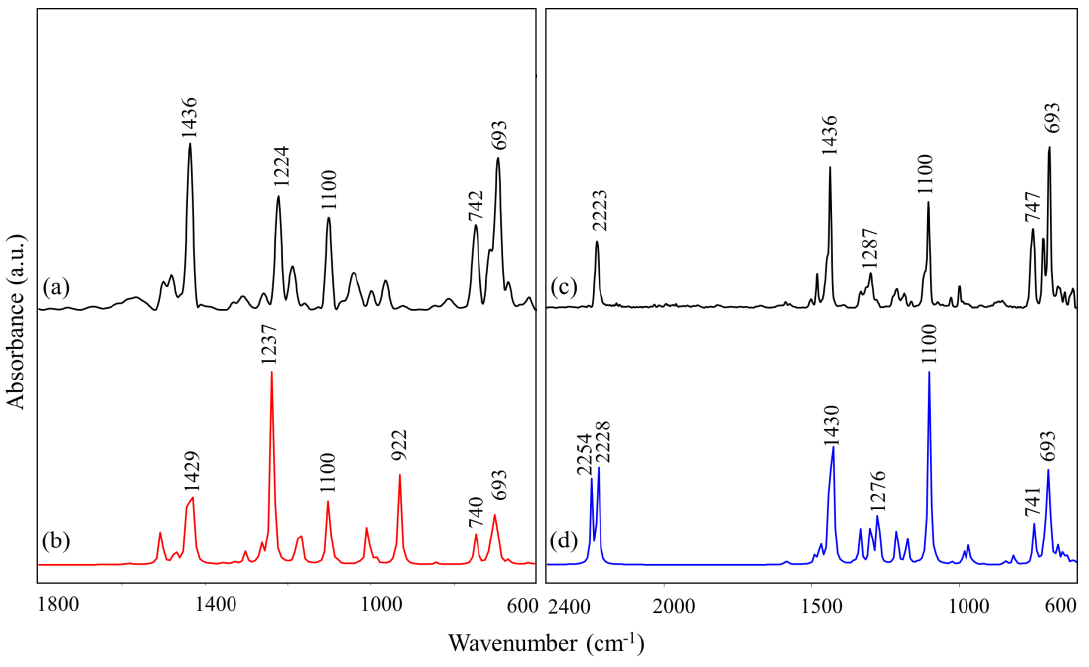
Figure 5. IR spectra of C-I (collected ( a ) and computed ( b ); 1800–600 cm − 1 spectral range), and C-II (collected ( c ) and computed ( d ); 2400–600 cm − 1 spectral range) drugs. The position (in terms of wavenumbers, cm −1 ) of the most significant peaks observed in C-I and C-II is shown.